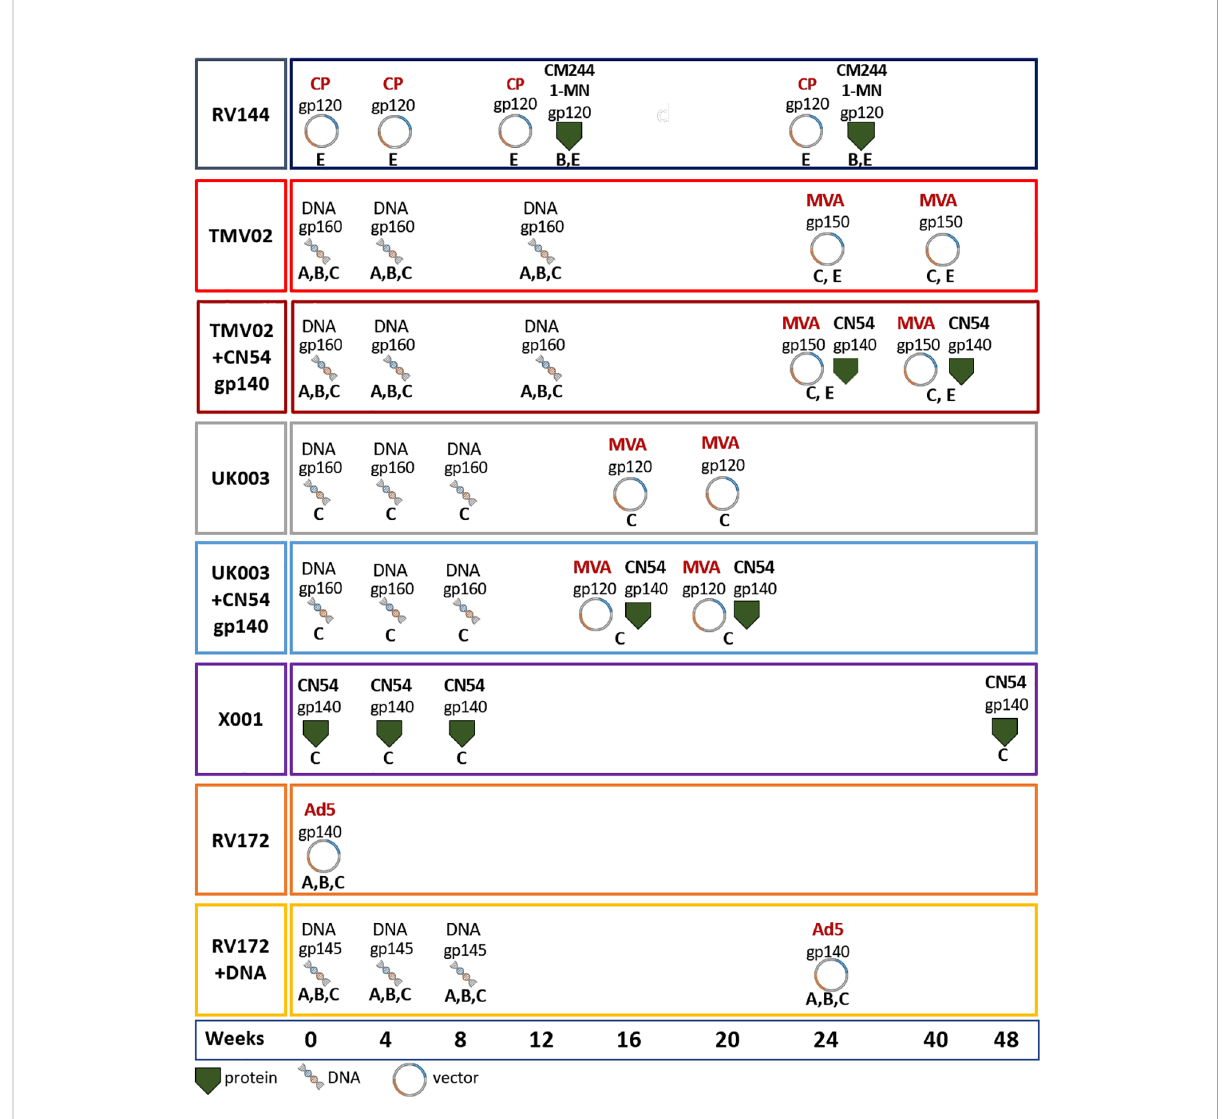
FIGURE 1 Vaccination schedules. Vaccination schedules and immunogens of the eight vaccination groups from fi ve different HIV vaccine trials analysed herein. For each vaccination group the molecular forms as well as the HIV-1 clade of the Env immunogens, their delivery form, and time point of administration are stated. The immunogens included: gp120 monomers, gp140 soluble trimers, open trimeric structures, membrane anchored gp145, ‘ native-like ’ gp150 including the transmembrane region and native trimeric gp160. Immunogens were either administered as adjuvanted proteins or expressed in vivo using DNA, MVA, CP and/or Ad5. Most groups received prime-boost vaccine regimens including multiple sequence variants of the Env (RV144, TMV02, RV172), while some included only CN54 derived immunogens (UK003, X001). The colour coding of the surrounding frame for each vaccination group is kept consistently in this article. Viral Vectors: MVA, Modi fi ed Vaccinia Ankara; CP, Canary Pox; Ad5, Adenovirus 5; Proteins: CM244, CRF01_AE strain; 1-MN = B-strain, CN54 =